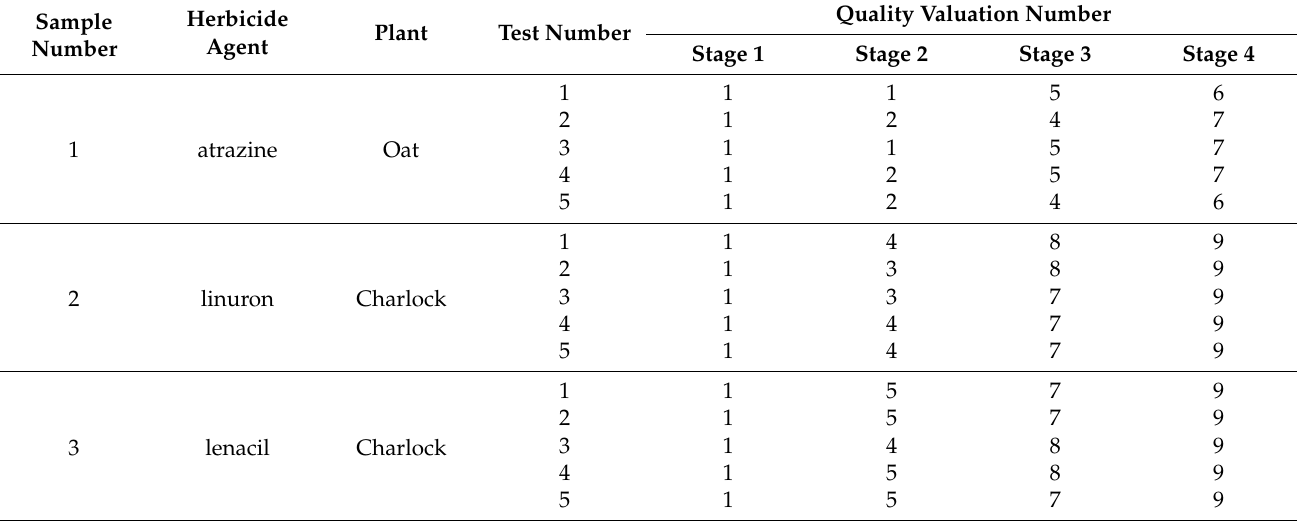
Table 7. Results of the 3rd series of biological tests (reference